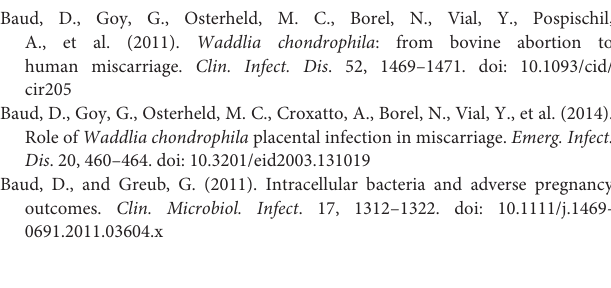
Supplementary Figure 2 | Images of enlarged organs after genital W. chondrophila challenge exhibiting lymphadenopathy, splenomegaly, hepatomegaly, and severe metritis. (A, C, E) organs from naive, uninfected mice. (B, D, F) enlarged organs (arrows) from mice infected with W. chondrophila .